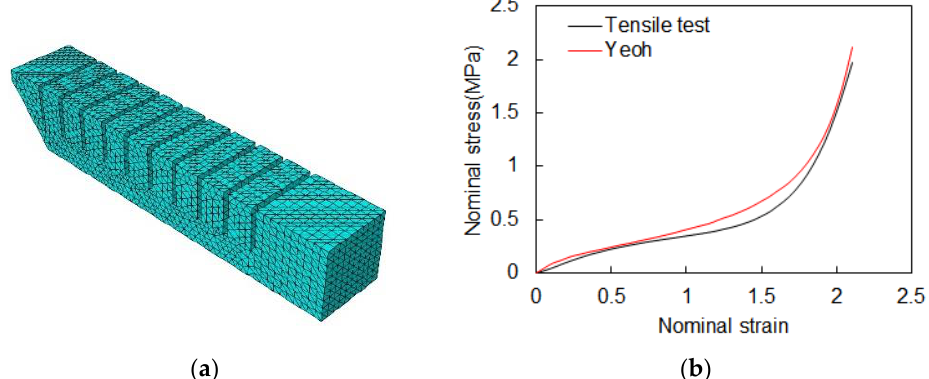
Figure 8. Definition of grid parameter model. ( a ) Finite element model of the finger; ( b ) stress and strain relationship for Dragon Skin 30.